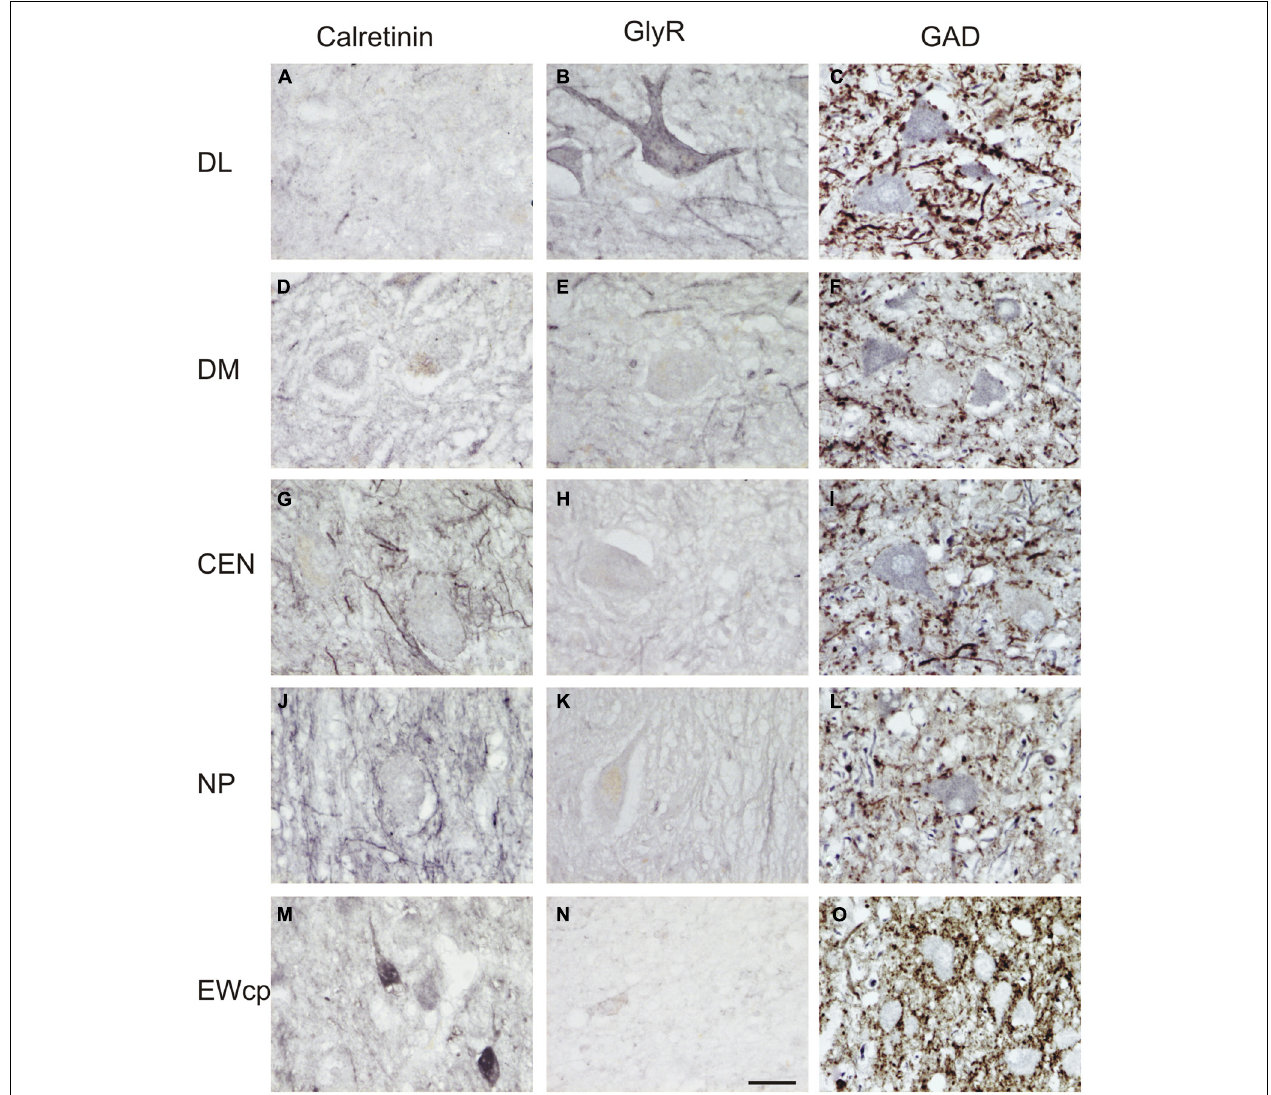
FIGURE 4 | High-power photographs of the staining pattern with different markers in the oculomotor nucleus complex. Numerous calretinin (CR)-positive profiles are found in association with cell bodies only in CEN and NP (G,J) , but not in DL, DM (A,D) . CR-staining of somata is found in EWcp ( M ; see also Figure 3 ). Strong labeling for glycine receptors (GlyR) is found only in the dorsolateral group (DL) (B) , and with some traversing fibers in the dorsomedial group (DM) (E) , but none in CEN, NP and EWcp (H,K,N) .